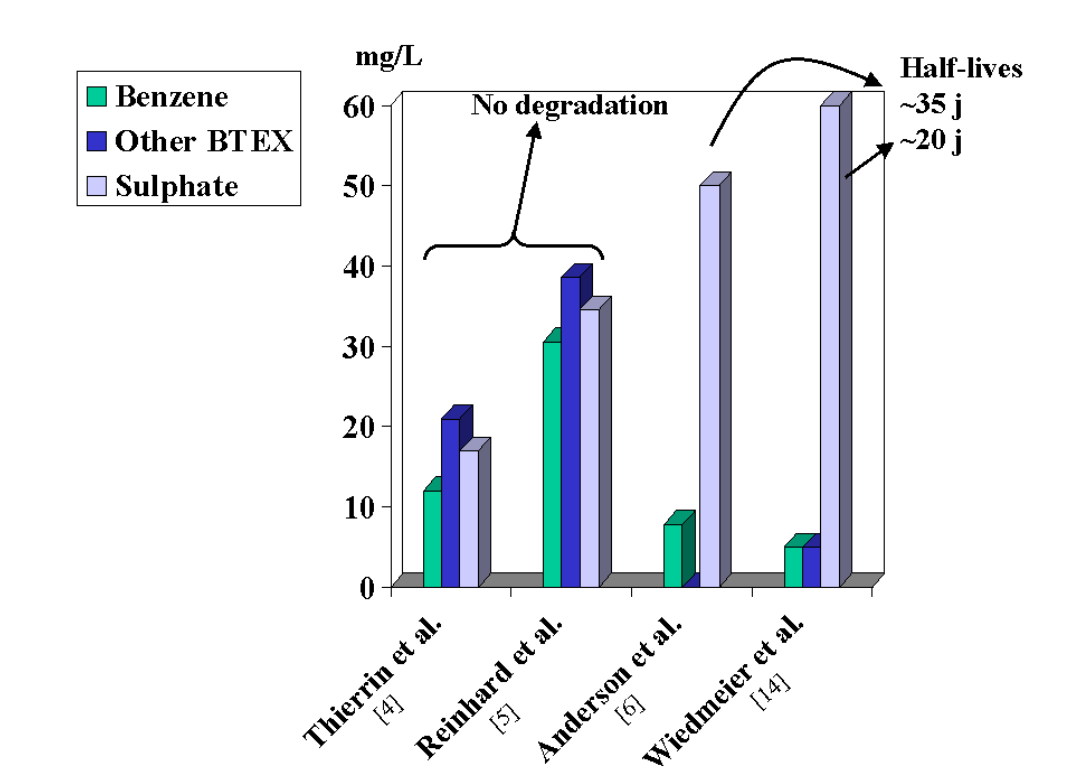
FIGURE 1. Benzene degradation under anoxic conditions, sulphate being the major electron acceptor. For each study, the amount of benzene, other BTEX, and sulphate present in water is shown. Benzene biodegradation half-lives were estimated in the